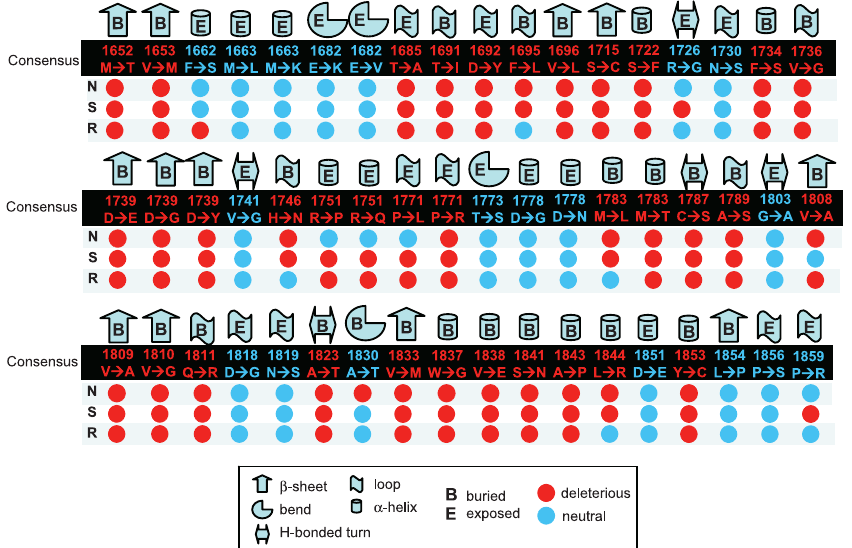
Figure 3. Computational Classifications of 54 Uncharacterized Variants Found in BIC For each variant, the local protein structure environment is represented by secondary structure type and whether the amino acid residue is buried ( normalized solvent accessibility , 0.2 ) or exposed ( normalized solvent accessibility (cid:3) 0.2 ). For the 54 uncharacterized variants, labels ( ‘‘ 1652 M- . T ’’ ) are colored according to consensus prediction from Naı¨ve Bayes, Support Vector Machine, and Random Forest. Predictions of each method are indicated by filled circles (blue, neutral; red, deleterious). N, Naı¨ve Bayes. R, Random Forest; S, Support Vector Machine.